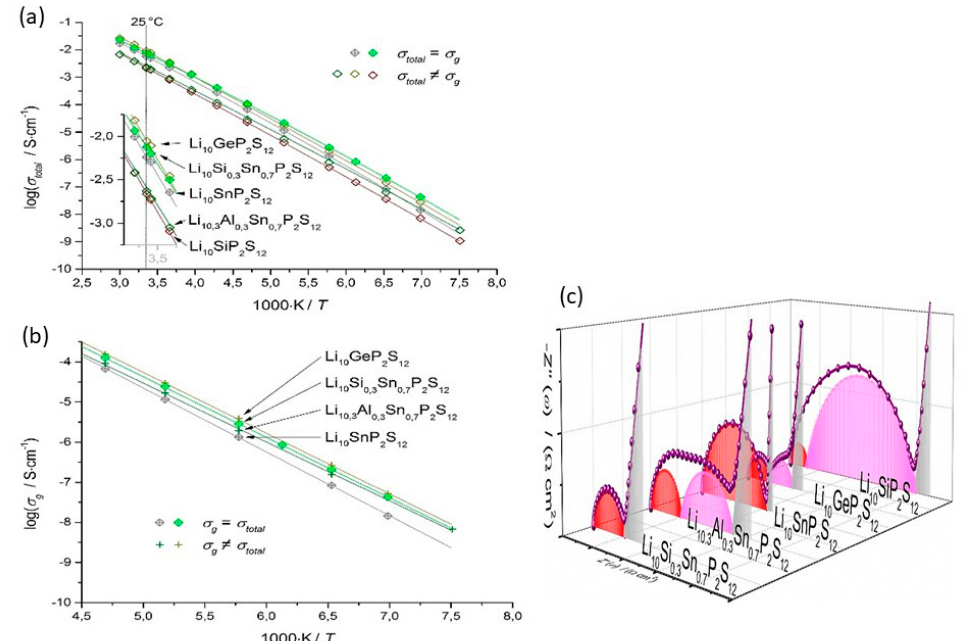
Figure 19. ( a ) Arrhenius plot of the total conductivities and quadratic best fit curves. The magnified image illustrates the temperature range of 0–40 ◦ C. ( b ) Arrhenius plot of the grain conductivities and corresponding linear best fits in the temperature range of − 140 to − 60 ◦ C. ( c ) Nyquist plots of electrolyte compositions. Reproduced with permission from [292]. Copyright 2016 Elsevier.